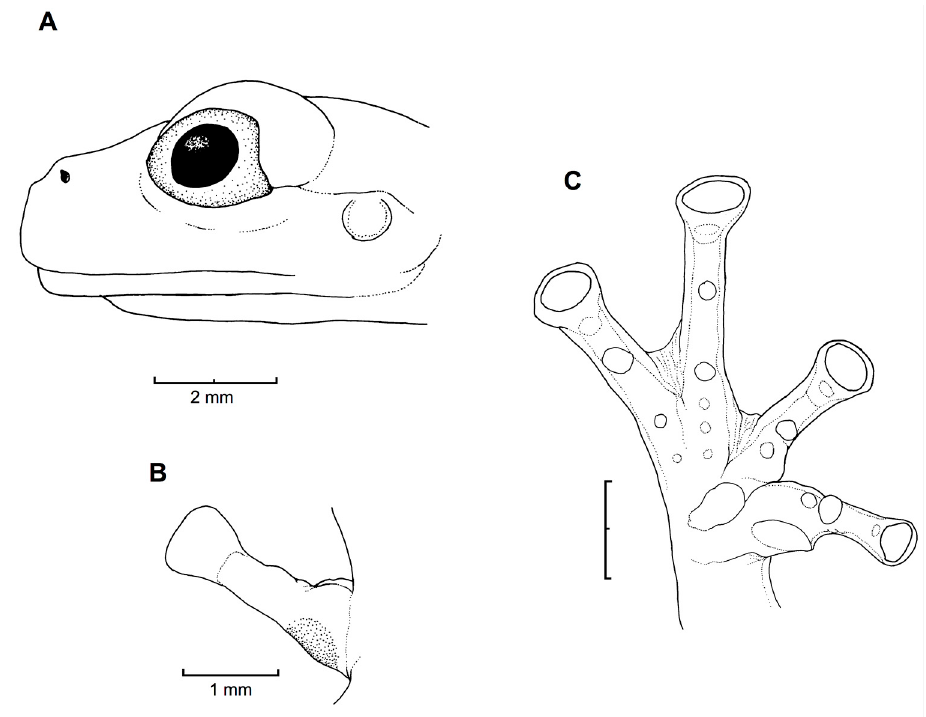
Figure 21. Centrolene ballux . ( A ) Head in lateral view, KU 164725. ( B ) Finger I and nuptial pad in dorsal view, KU 200275, adult male. ( C ) Hand in ventral view, KU 164725. Illustrations by Juan M. Guayasamin.